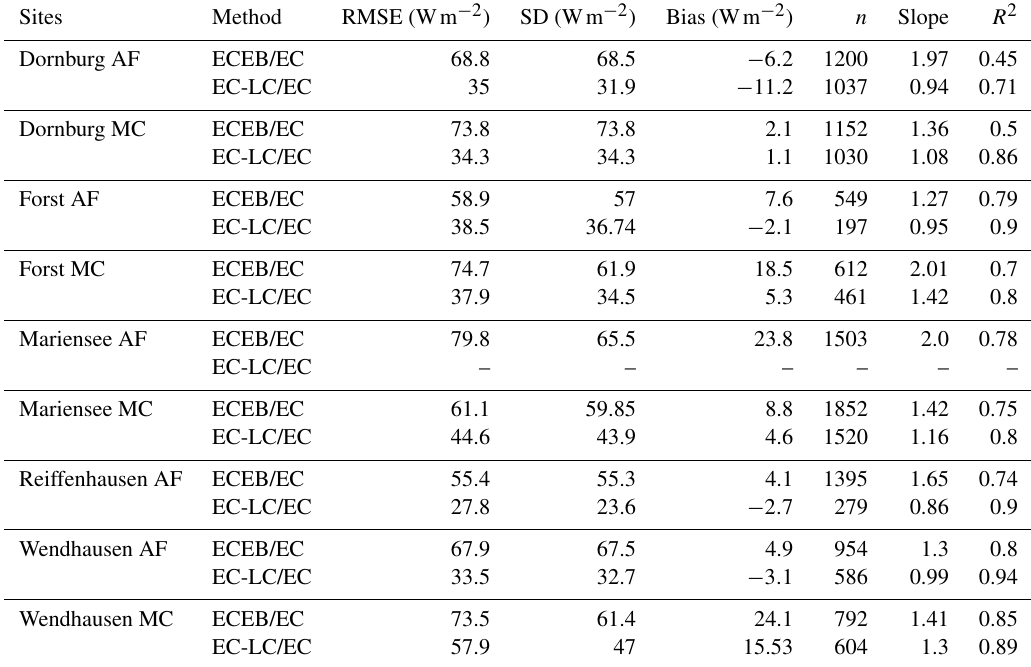
Table 4. Statistical analysis results for a linear regression of LE EC-LC vs. LE EC and LE ECEB vs. LE EC . Shown here are the root mean square error (RMSE), the standard deviation of the differences between both set-ups (SD), the bias (Bias), the number of points used for the analysis ( n ), the slope for a linear regression of LE EC-LC vs. LE EC and LE ECEB vs. LE EC , and the coefficient of determination of the linear regression ( R 2 ). Data for LE EC-LC at Mariensee AF are missing due to technical problems with the sensor during the campaign, and data for Reiffenhausen MC are missing due to the unavailability of a